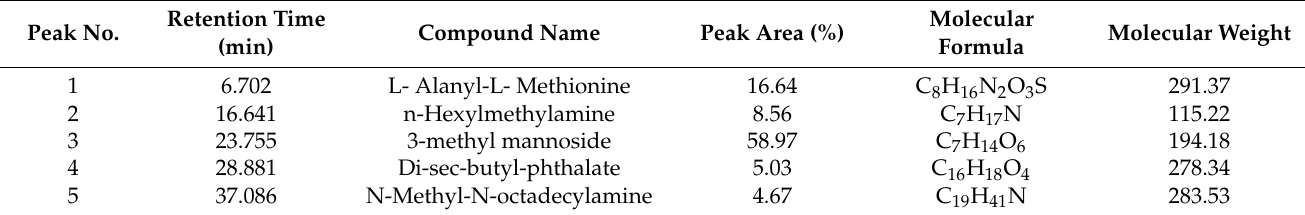
Table 1. Compounds present in chloroform: methanol extract of CA by GC-MS analysis. Peak